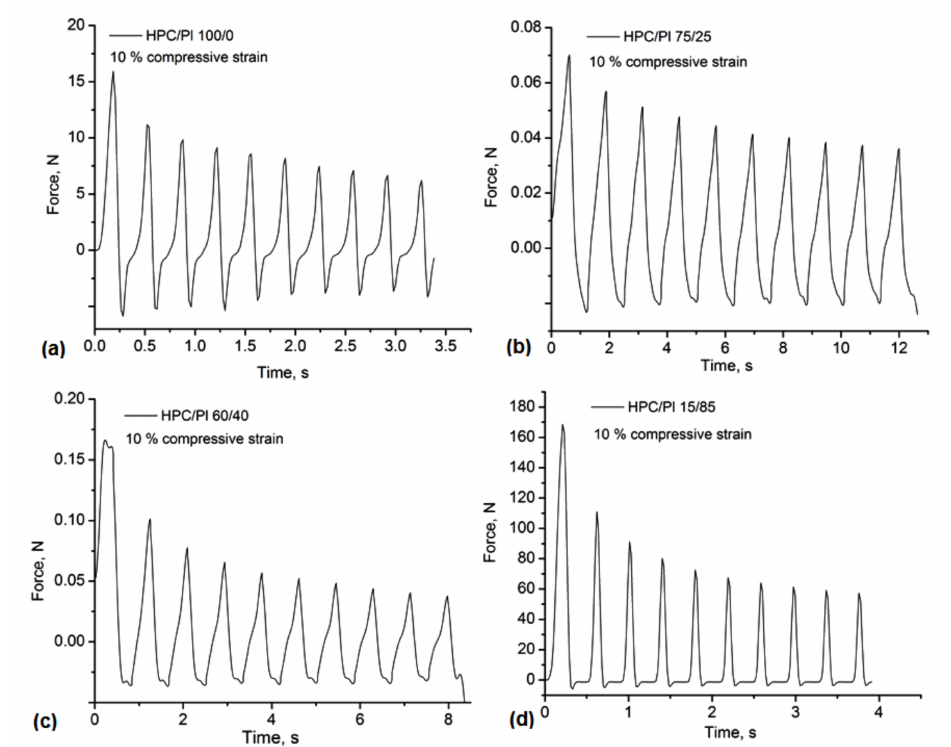
Figure 5. Compression tests of the monoliths under 10% compressive strain: ( a ) HPC/Pl 100/0;